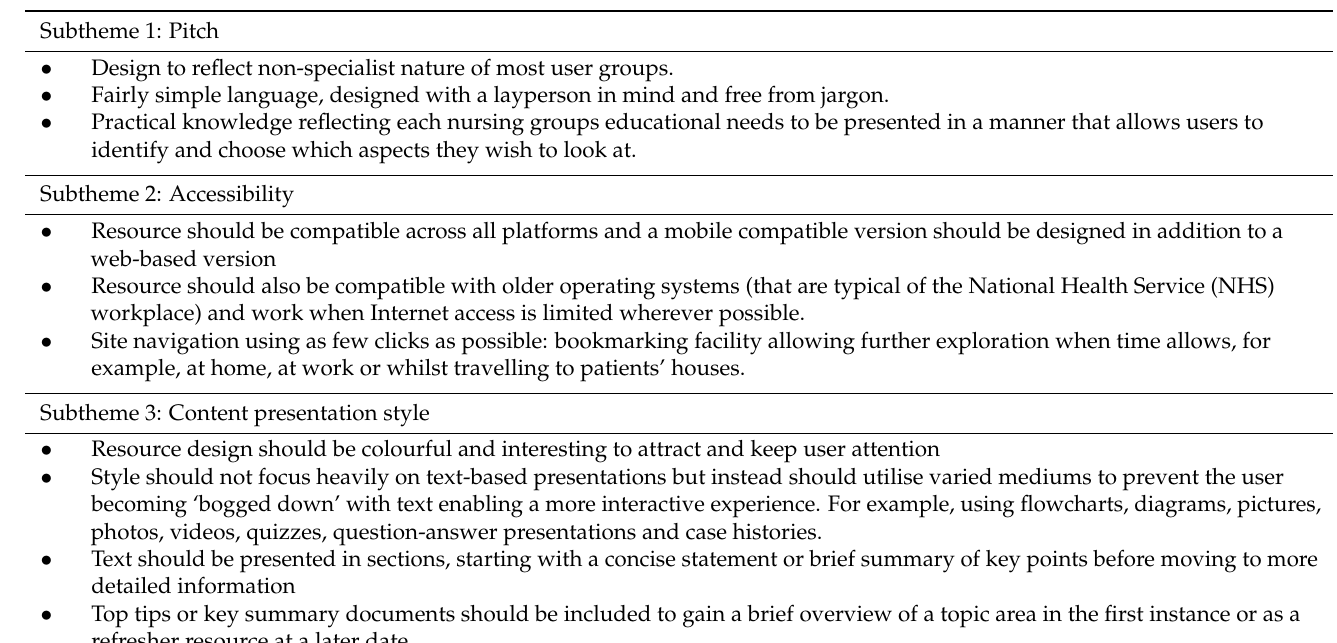
Table 2. Design Components to Consider for an Impactful Learning and Information